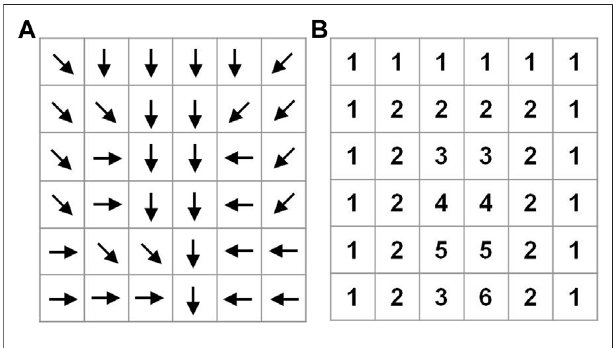
FIGURE 1 | Flow direction (A) and different level of priority (B)